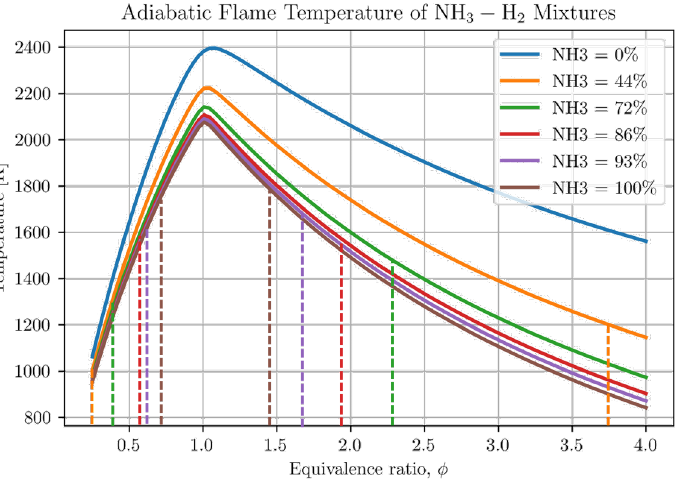
Figure 1. The adiabatic flame temperature of NH 3 -H 2 mixtures as a function of equivalence ratio and the associated flame stability limits [12,13]. The simulations use the Stagni et al. [21] combus- tion